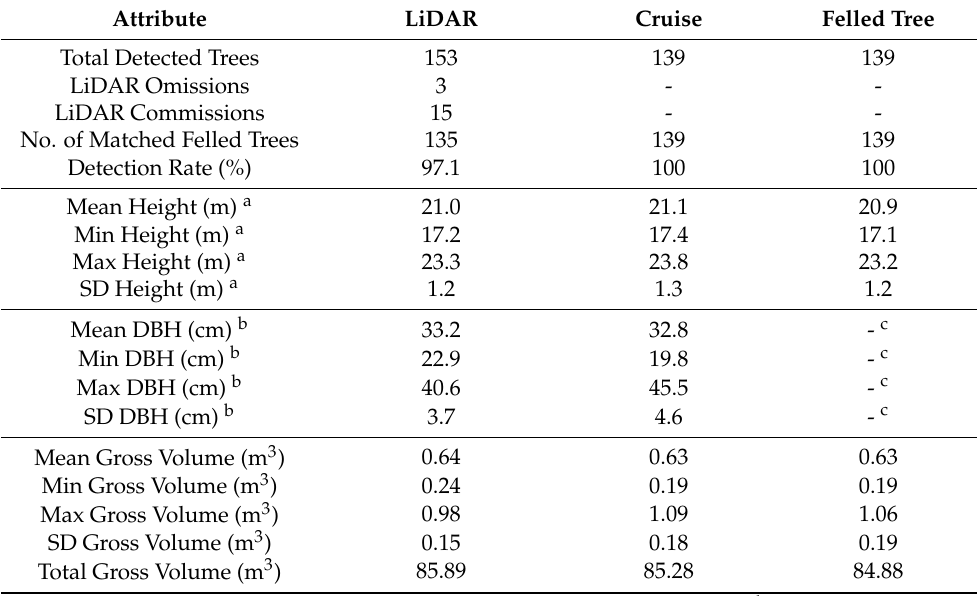
Table 1. Summary of December 2020 ALS, May 2021 cruise data, and May 2021 felled tree measure- ment data within the 0.5 ha study site ~44 km northwest of Nacogdoches, Texas (Latitude 31.75 Longitude − 95.09).